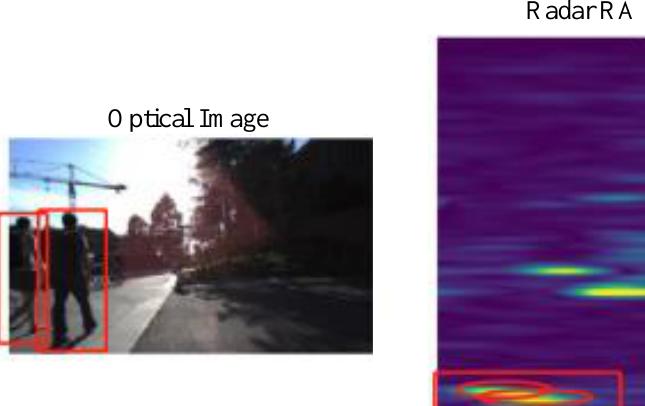
Figure 3. RODNet radar data target-detection results from left to right are optical image, radar RA map (Input data, two walking persons in red box), and radar detection results. The ConfMap of a certain class predicated by CNNs-based RODNet is believed